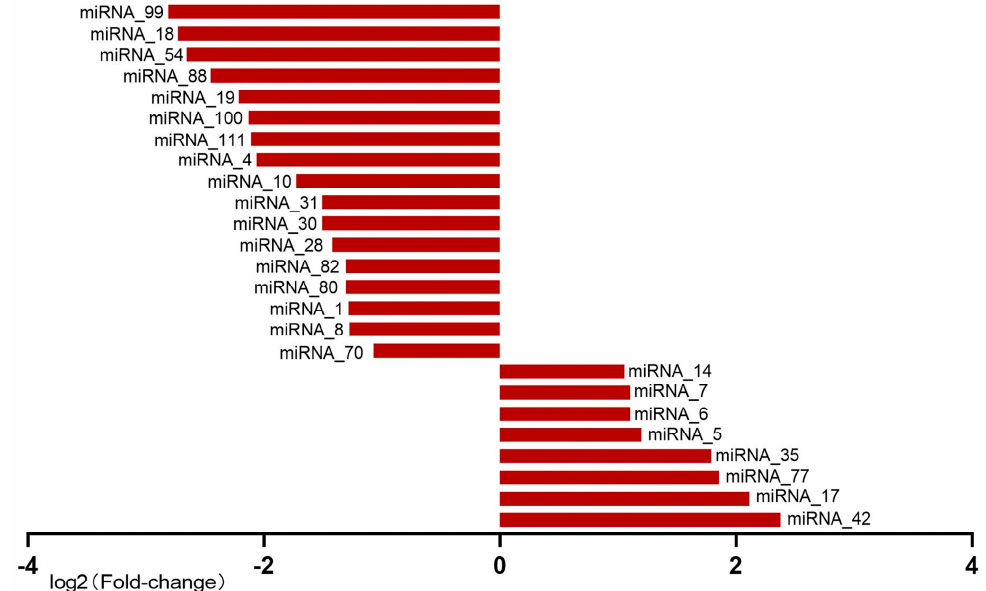
Figure 3. Differentially expressed miRNAs in WT compared with AL Andrias davidianus skin. A total of 25 differentially expressed miRNAs were identified based on the criteria of |logFC| ≥ 1 and p adj value ≤ 0.05.